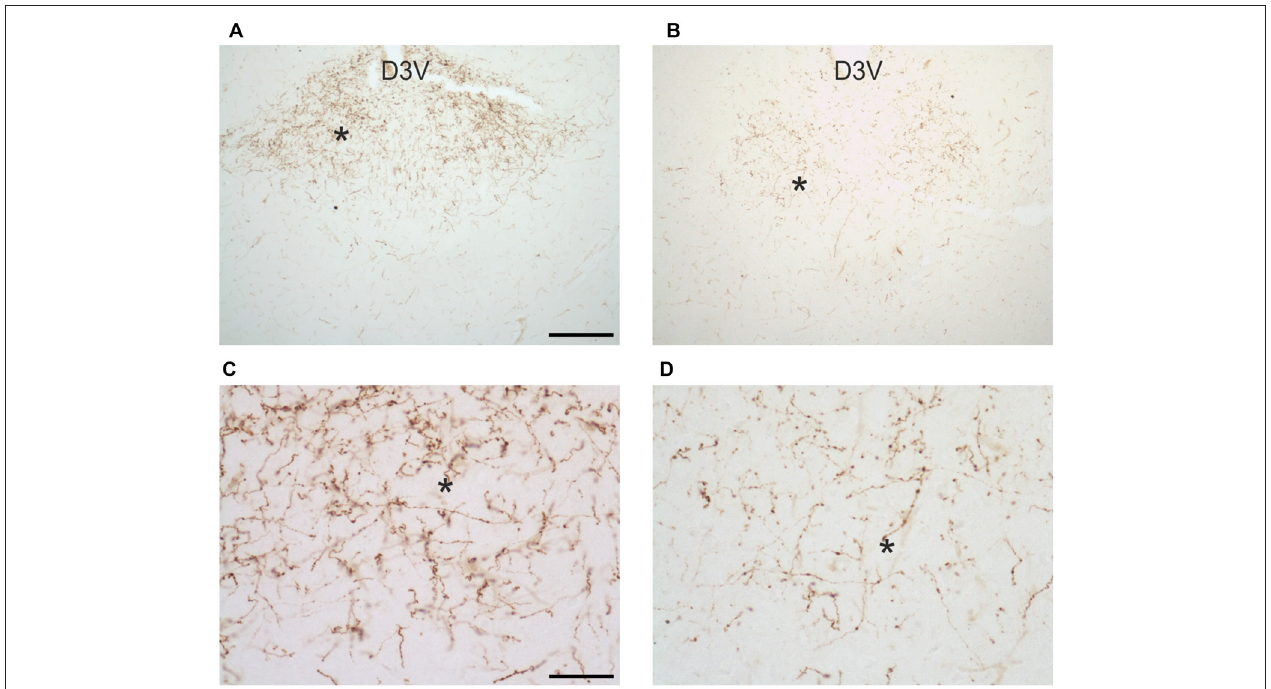
FIGURE 8 | Images of orexin-A-immunoreactive preterminal and fibers in the paraventricular thalamic nucleus of uninfected Mastomys natalensis (A,C) and at 8 weeks after infection with Trypanosoma brucei gambiense (B,D) . (C,D) represent at higher magnification fields of (A,B) , respectively, as indicated by the asterisks for spatial landmark. Note in (C) the abundance of varicose fibers in the control animals and note in (D) their marked decrease and fragmentation in the infected animal. Abbreviation: D3V, dorsal third ventricle. Abbreviation: D3V, dorsal third ventricle. Scale bars: 200 µ m in (A,B) , 50 µ m in (C,D)